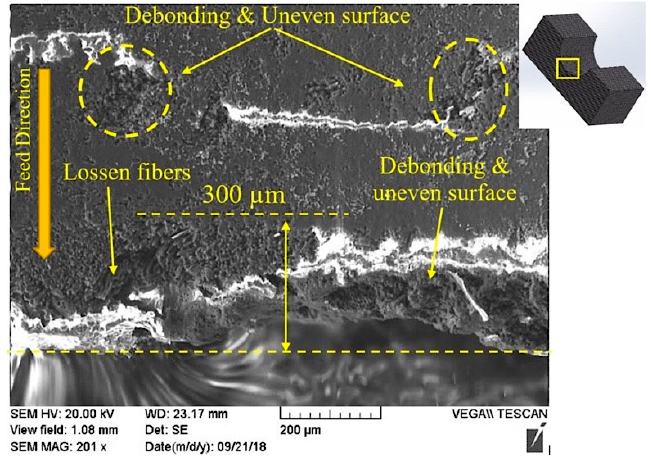
Figure 13. The SEM examination of CD machined hole at f = 0.075 mm /rev and N = 3000 rpm. J. Manuf. Mater. Process. 2019 , 3 , x FOR PEER REVIEW